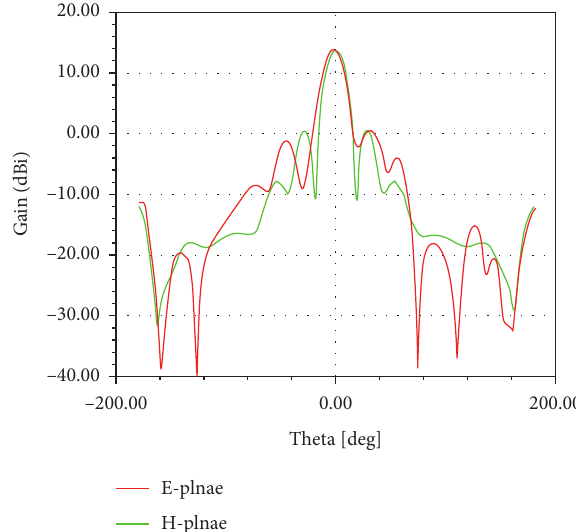
Figure 9: Proposed 34 elements thinned array antenna radiation pattern in E-plane and H-plane in HFSS.